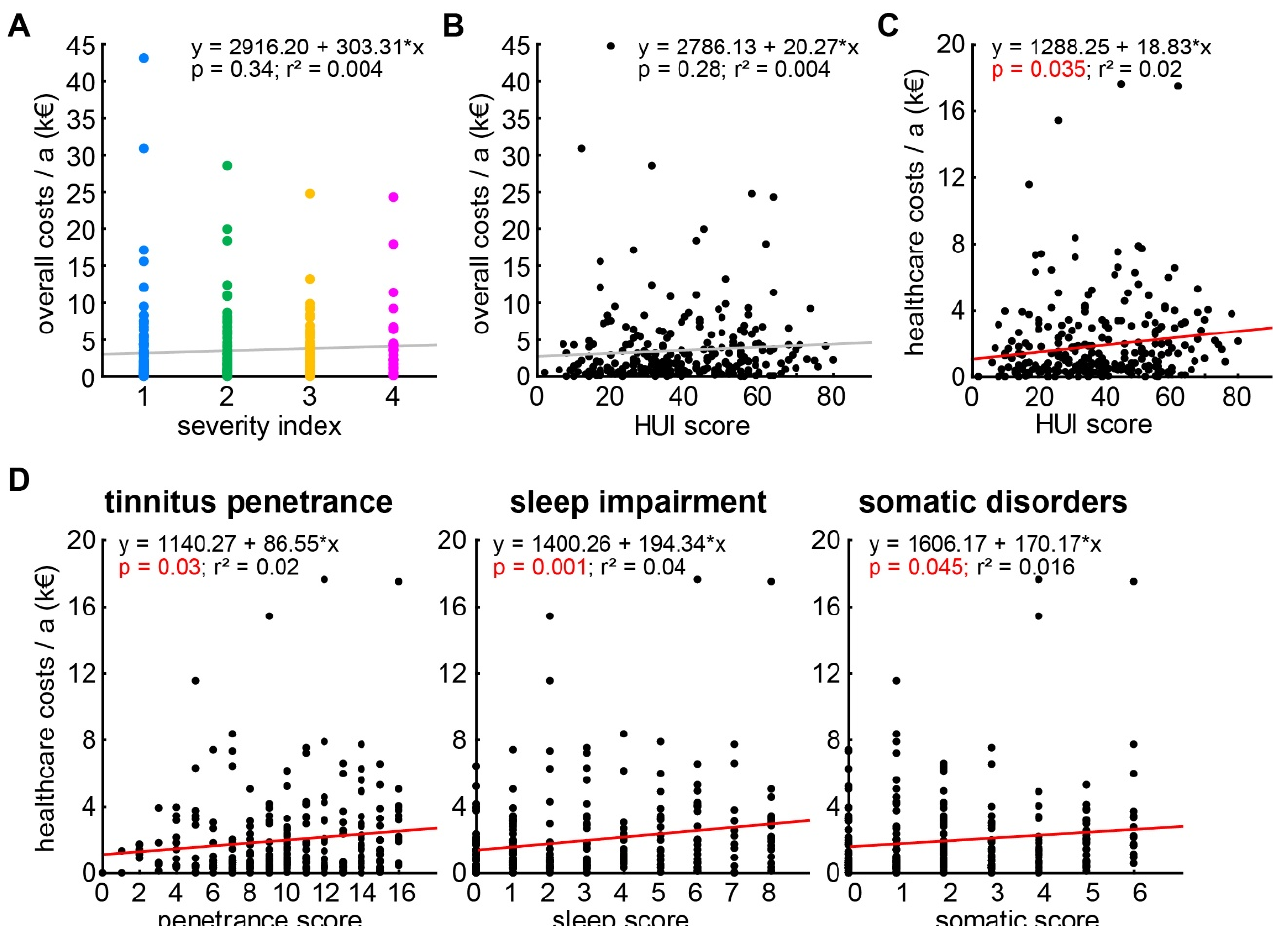
Figure 2. Multiple linear regression analyses of overall and healthcare costs with tinnitus severity index and HUI score/sub-scores. ( A ) No significant regression for the individual overall costs and the tinnitus severity index. Severity index color scheme as in Figure 1. ( B ) No significant regression (grey line) for the overall costs and the HUI score. ( C ) Significant linear regression (red line) for the healthcare costs and the HUI score. ( D ) Significant linear regressions (red lines) for the healthcare costs and the HUI sub-scores tinnitus penetrance, sleep impairment, and somatic disorders.